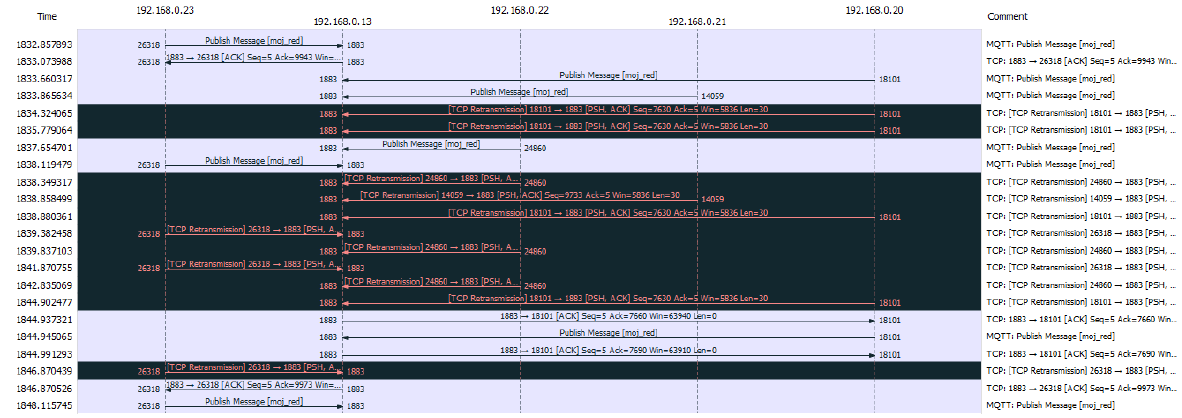
Figure 12. Communication flow between the server and the four sensor nodes with error packets.